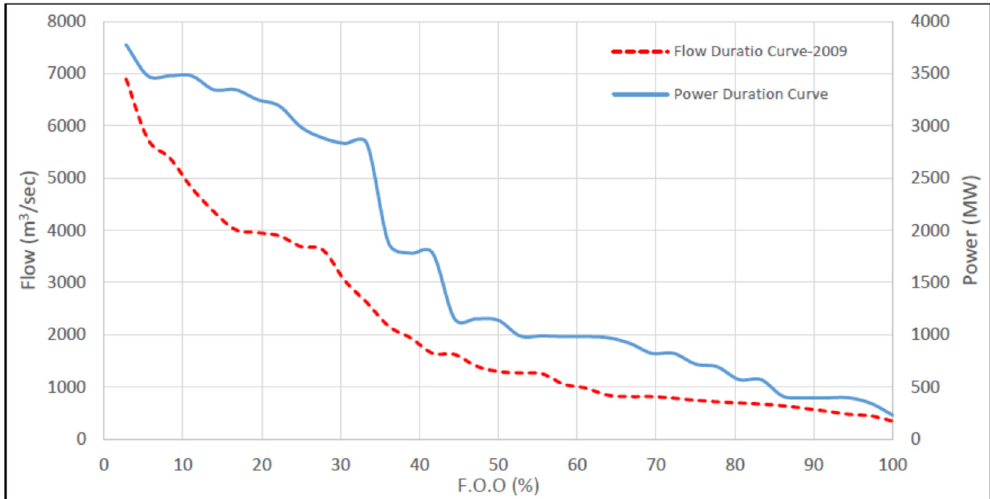
Figure 37. Flow and Power Duration curves for year 2009.